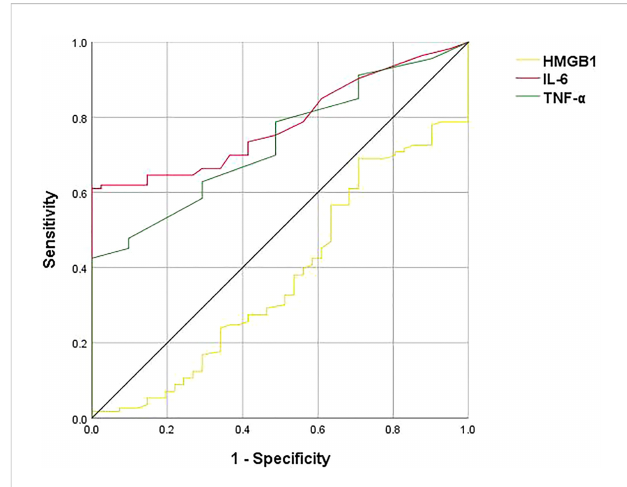
FIGURE 1 ROC curve analysis of HMGB1, TNF- a , IL-6, the black line represents HMGB1, the green line represents TNF- a , and the red line represents IL-6. The ROC curves showed that the AUCs of HMGB1, TNF- a , and IL-6 are 0.375, 0.733, and 0.783, respectively.